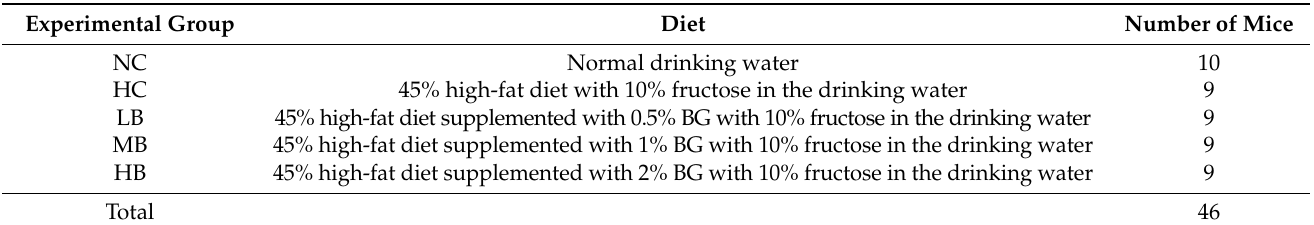
Table 1. Experimental design of the